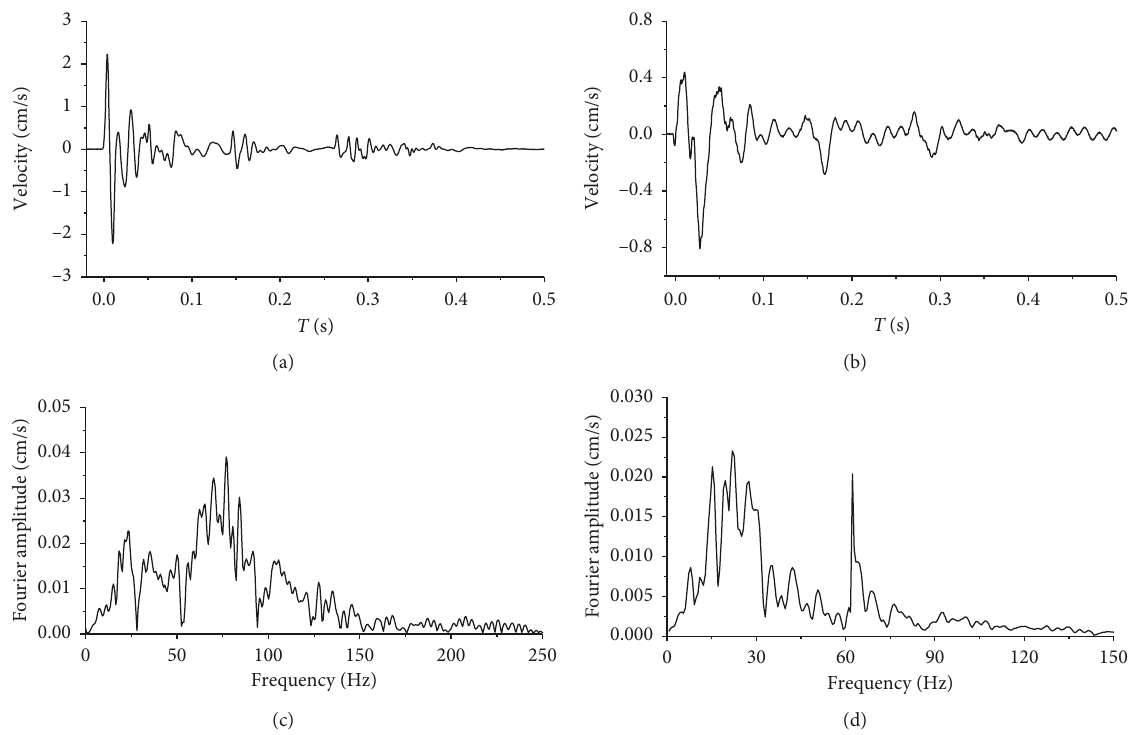
Figure 3: Time history of velocity and Fourier amplitude of Z and X blast vibrations. (a) Z direction blast vibration. (b) X direction blast vibration. (c) Z direction blast vibration Fourier amplitude. (d) X direction blast vibration Fourier amplitude.